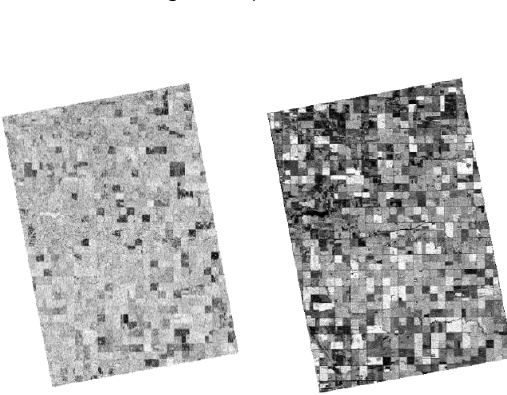
Figure 2 . Span and RVI